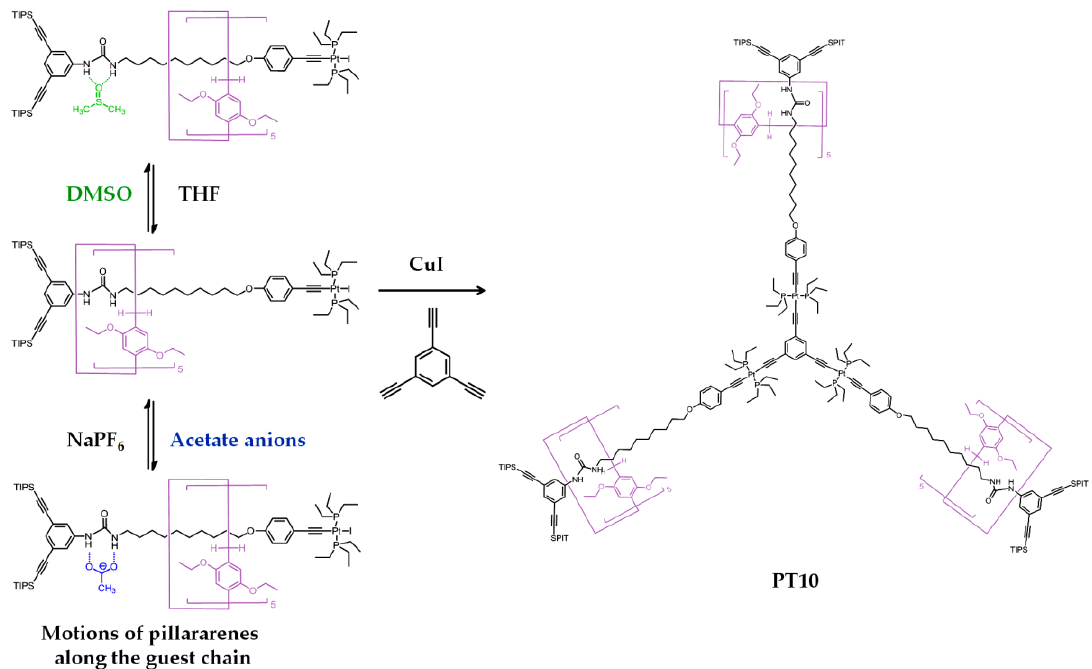
Figure 2. Synthesis of mechanically interlocked molecule PT10 by the CuI-catalyzed coupling reaction between star-shaped molecule—1,3,5-triethynylbenzene and pseudorotaxane X12 ⊃ G9 , as well as the solvent / anion-induced switchable motions of the wheel— X12 along neutral alkyl chain guest G9 [27]. External stimuli responsiveness could be indicated by the chemical structural changes.